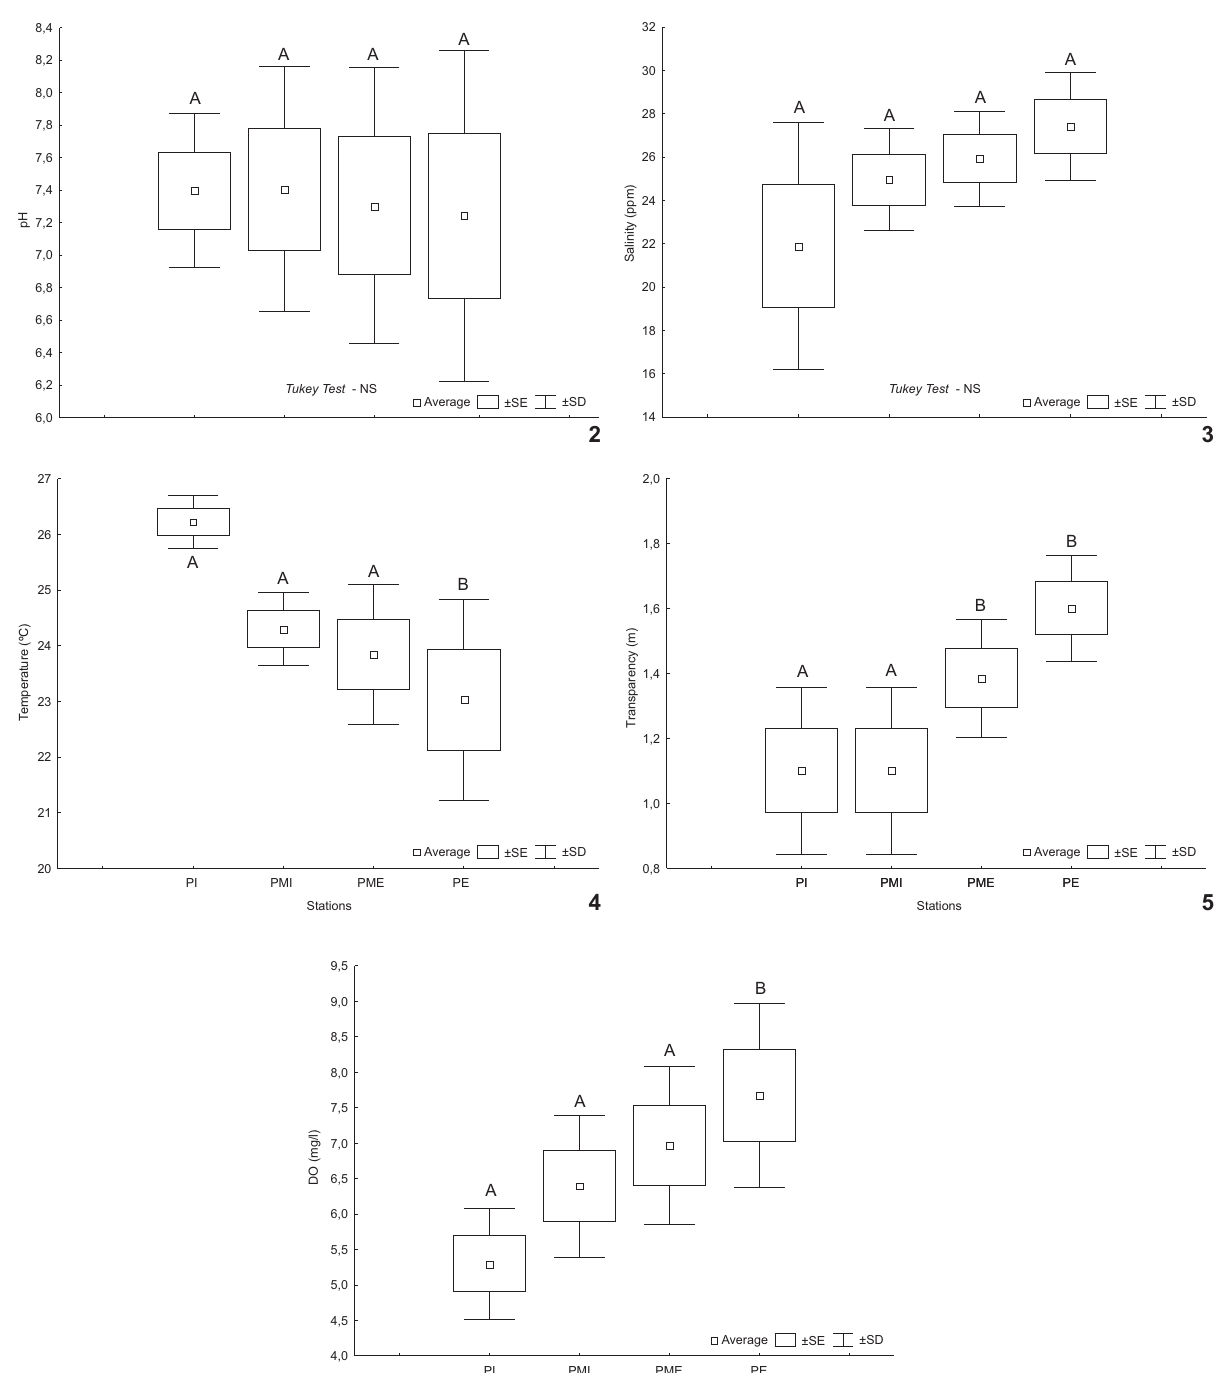
Figures 2-6. Mean values, error (EP) and standard deviation (SD) of the environmental parameters of six samples monitored at the four study stations PI (Internal Station), PMI (Internal Midpoint), PME (External Midpoint) and PE (External Station) along the Vitória Harbor. The letters A and B indicate homogeneous groups (nonparametric Tukey Test, p <